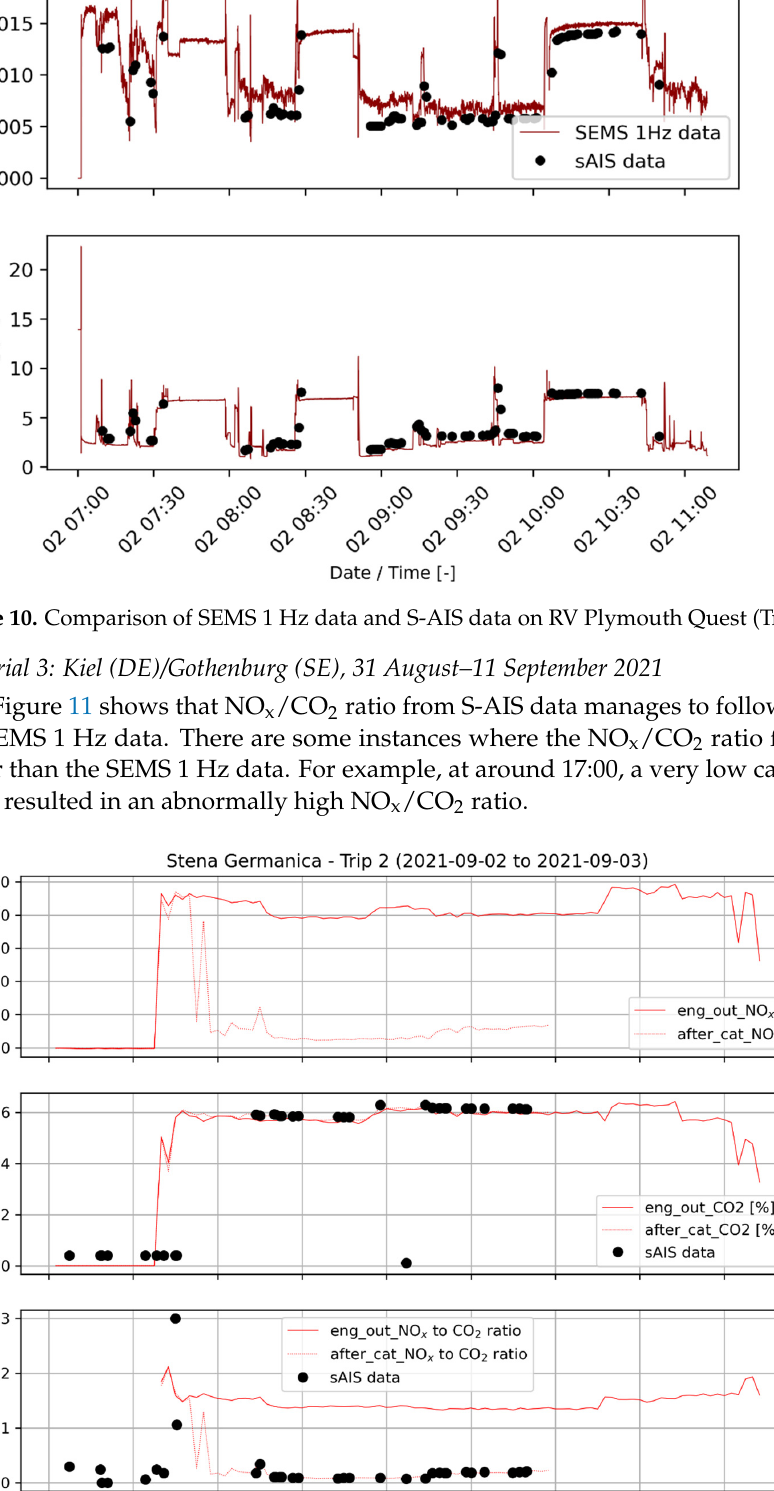
Figure 9. Comparison of SEMS 1 Hz data and S-AIS data on RV Plymouth Quest (Trip 9).